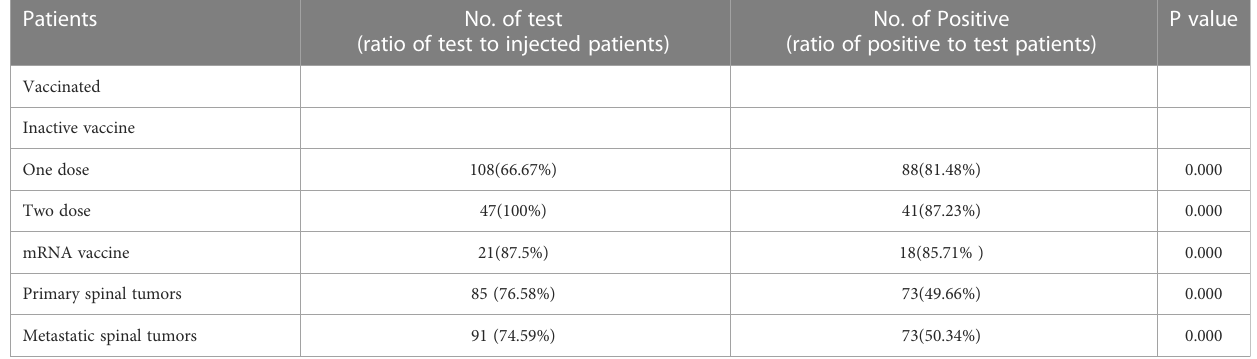
TABLE 2 Ef fi cacy of serologic response in patients treated by denosumab and vaccine.